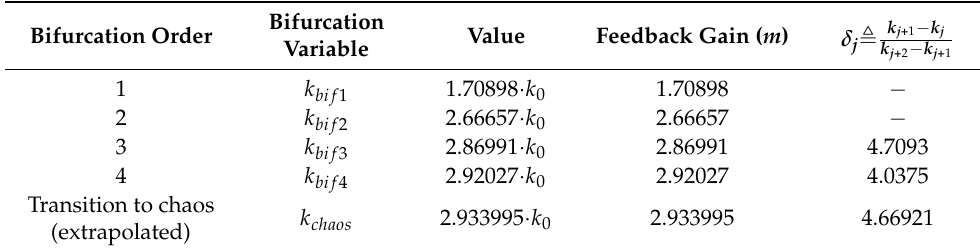
Table 7. Bifurcation points for the reduced-order BWR model by March-Leuba, Cacuci, and Perez (1984).